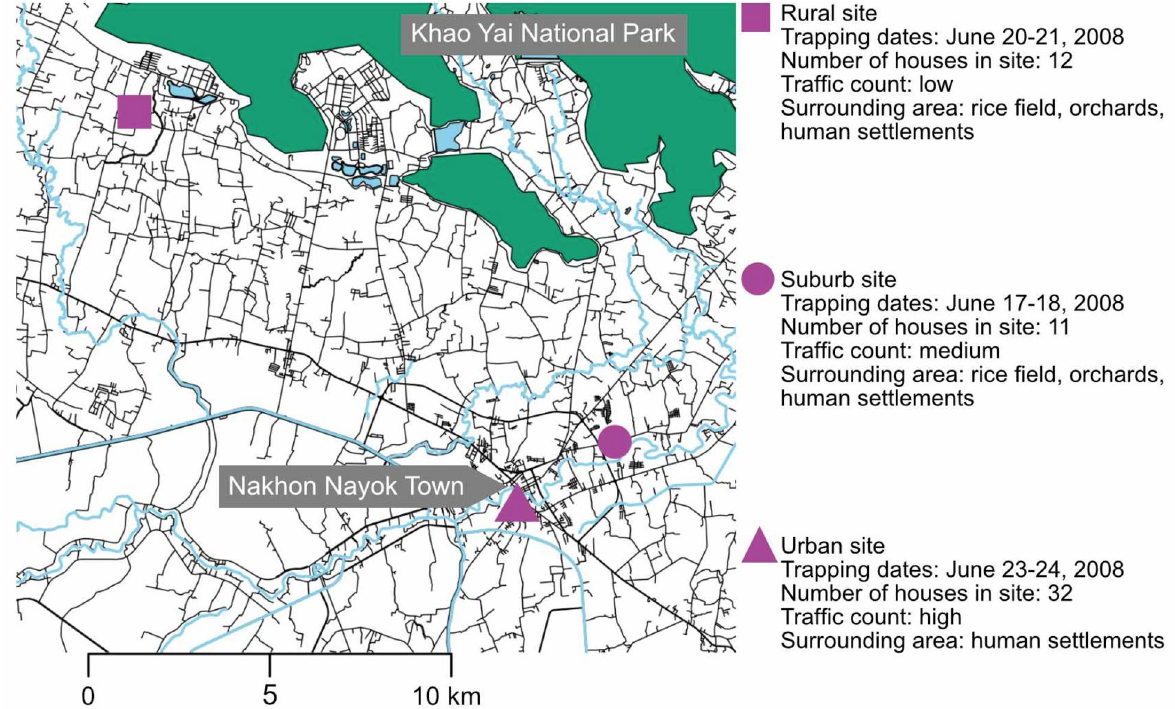
Figure 1. Three study sites located along an urbanization gradient in Nakhon Nayok province of central Thailand. Detailed habitat characteristics can be found in our previous publication 27 . The map was created using R v3.5.3 (www.r- proje ct.